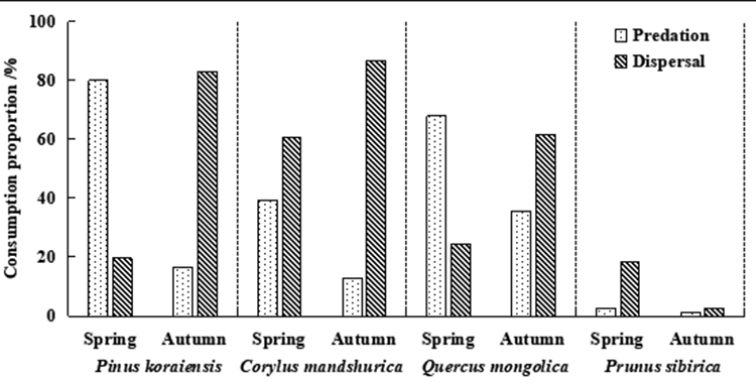
Predation rate and dispersal rate of four kinds of seeds combined in spring and autumn in temperate forests of Northeast China.